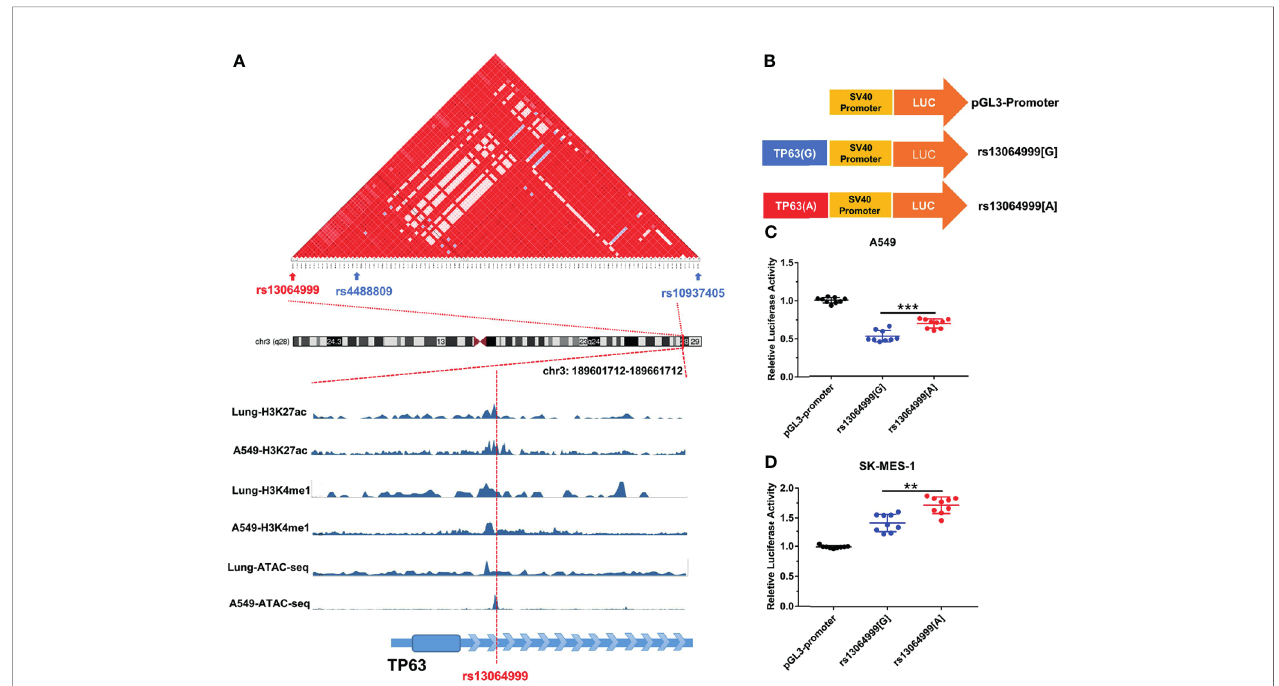
FIGURE 1 | The variant rs13064999 in fl uence gene transcription. (A) The bioinformatic analysis of rs13064999. Top, LD map of a total of 141 common SNPs in the 3q28 locus. Bottom, epigenetic tracks for the region surrounding SNP rs13064999 from ENCODE database. (B) The diagram of the recombinant plasmid used in luciferase assays. DNA fragments containing rs13064999[G/A] were cloned into pGL3-Promoter vector. (C, D) Relative reporter gene activity of the constructs containing rs13064999 G or A allele in A549 cells (C) and SK-MES-1 cells (D) , respectively. Data were presented as mean ± SD from three independent experiments, each in triplicate. *** p < 0.001, ** p < 0.01; p -values were calculated by a two-sided Student ’ s t